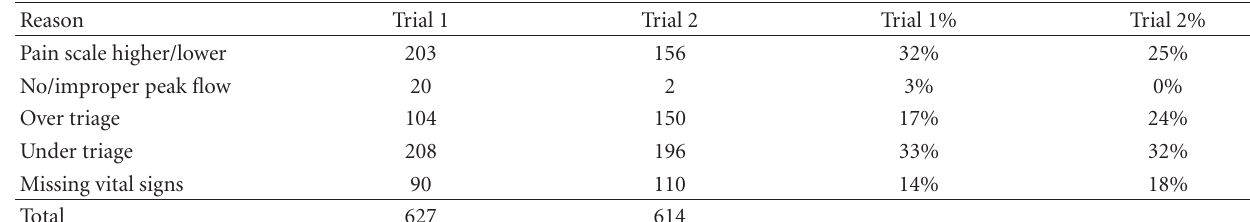
Table 7: Reasons for Canadian Triage and Acuity Scale (CTAS)